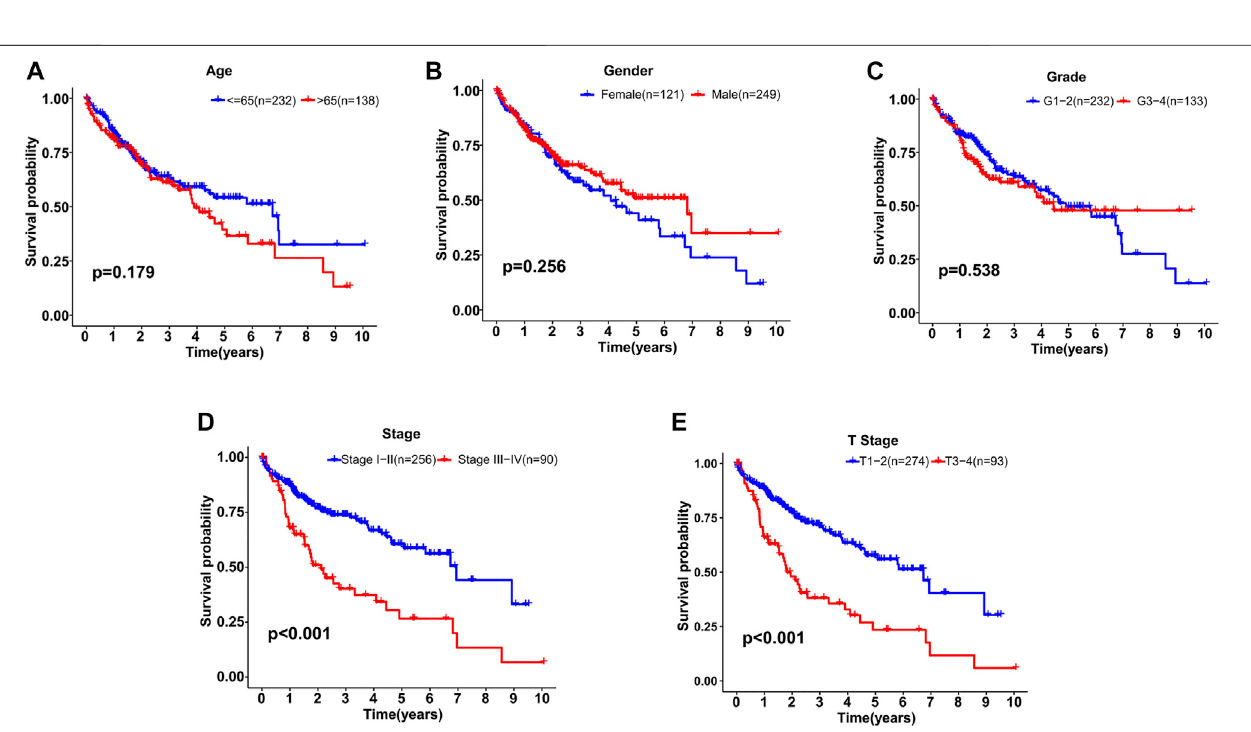
FIGURE 7 | Kaplan – Meier survival analyses of patients with different clinical characteristics. (A) Age. (B) Gender. (C) Grade. (D) Stage. (E) T